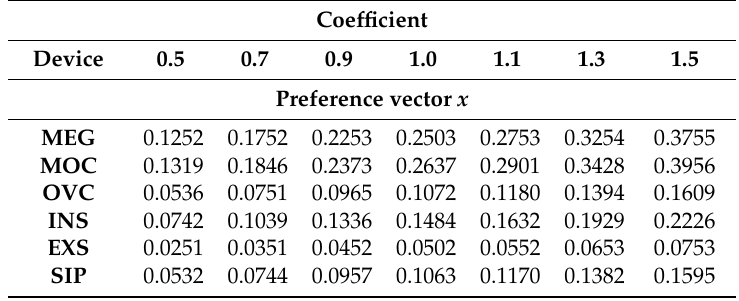
Table 10. Results of the sensitivity analysis simulations for the preference vector x .